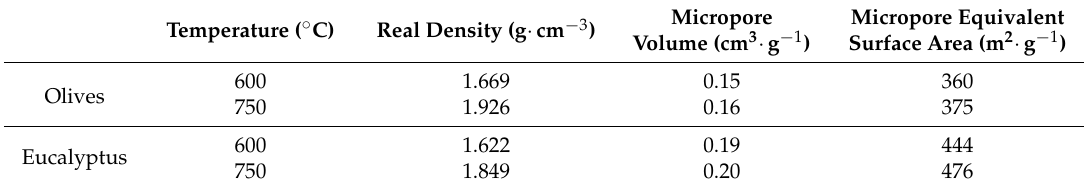
Table 6. Effect of the temperature in the textural characterization of the bioreducers (20 °C · min − 1 ).